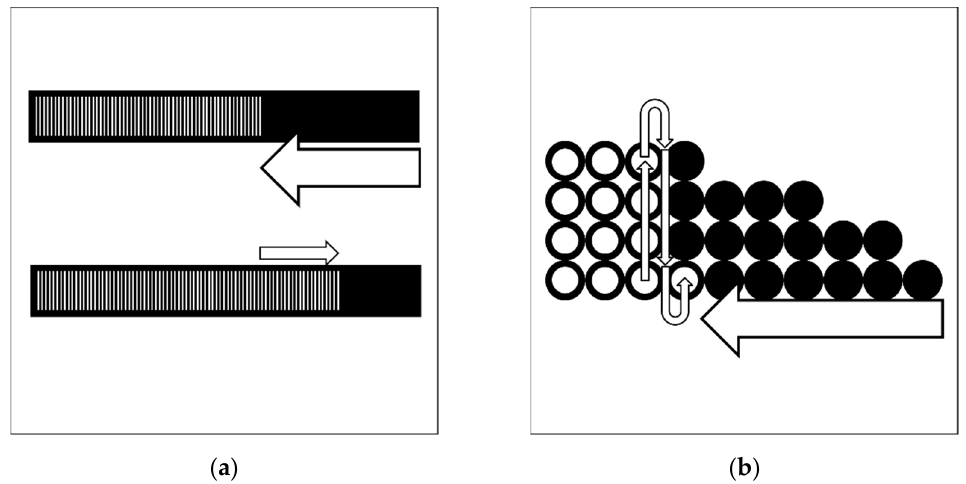
Figure 2. Mockups of the interface elements that show the player the state of the stamina variable before and after the game starts presenting a dynamic analog dilemma: ( a ) fixed rate of depletion and replenishment; ( b ) spending one unit of the in-game stamina resource depletes an entire row, right to left, but replenishment of a unit only occurs after all cells in a row are refilled, bottom to